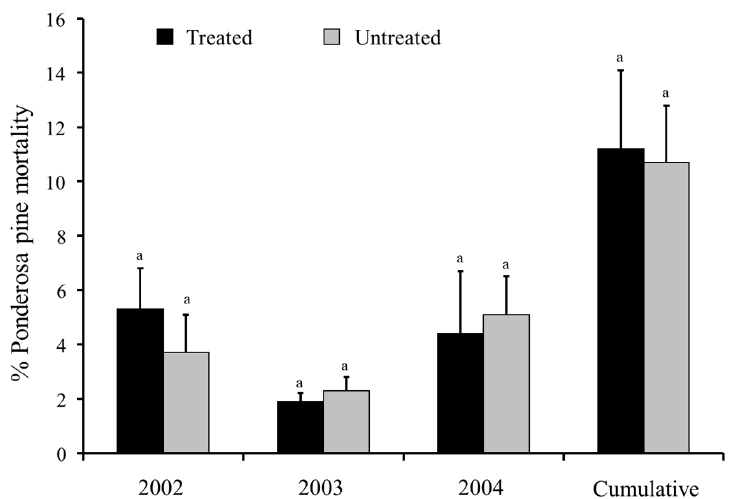
Figure 5. Mean percentages (+SEM) of ponderosa pines ( Pinus ponderosa ) killed by western pine beetle ( Dendroctonus brevicomis ) in verbenone-treated and untreated plots, California. Bars preceded by the same letter within year and cumulatively (2002–2004) are not significantly different ( p > 0.05; Tukey’s HSD). Adapted from Fettig et al. [57].